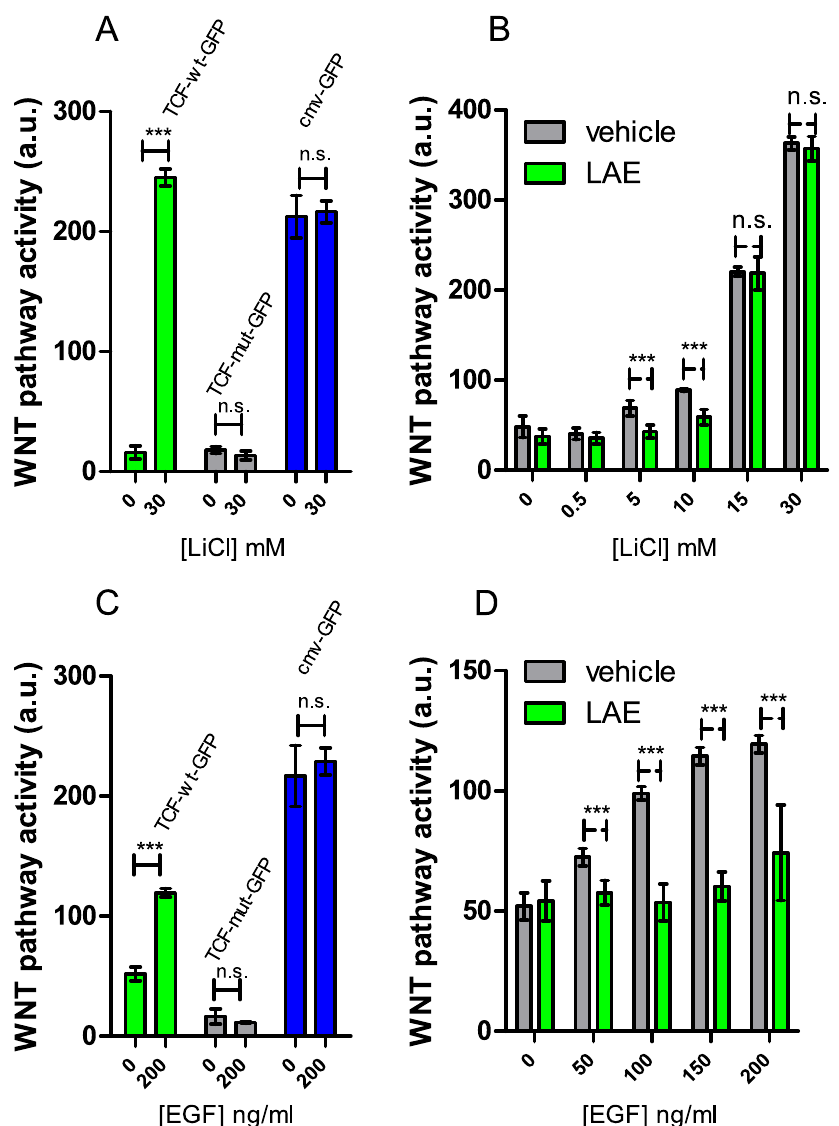
Figure 3. LAE inhibits the WNT pathway, acting downstream to APC. ( A ) The histogram shows the WNT pathway activity induced by LiCl (30 mM) in HEK293 cells transfected with TCF-wt GFP (green bars), TCF-mut GFP (grey bars) and cmv GFP (blue bars); ( B ) WNT pathway activity of cells treated with the indicated concentration of LiCl in the presence (green bars) or in the absence (grey bars) of LAE (400 mg/L); ( C ) WNT pathway activity induced by EGF (200 ng/mL) in HEK293 cells transfected with TCF-wt GFP (green bars), TCF-mut GFP (grey bars) and cmv GFP (blue bars); ( D ) WNT pathway activity of cells treated with the indicated concentration of EGF in the presence (green bars) or in the absence (grey bars) of LAE (400 mg/L). Values are reported as mean ± SEM ( n = 5). *** p < 0.05, n.s. indicates